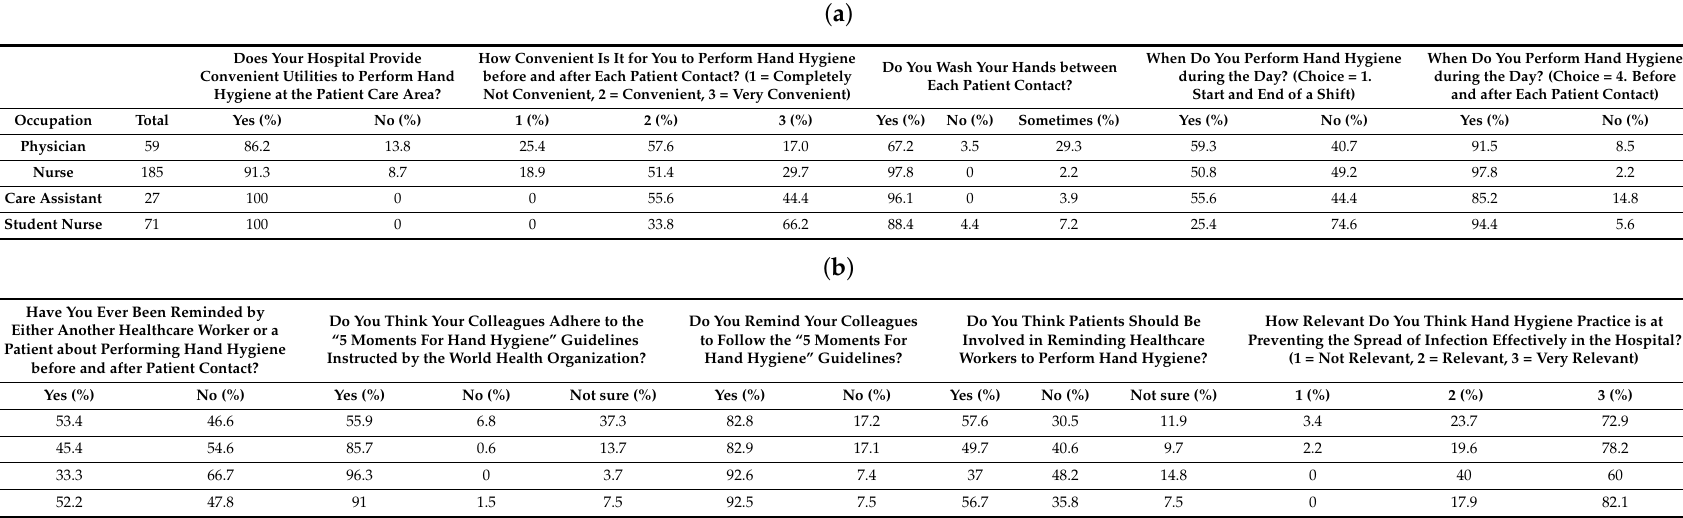
Table 1. Survey responses from healthcare